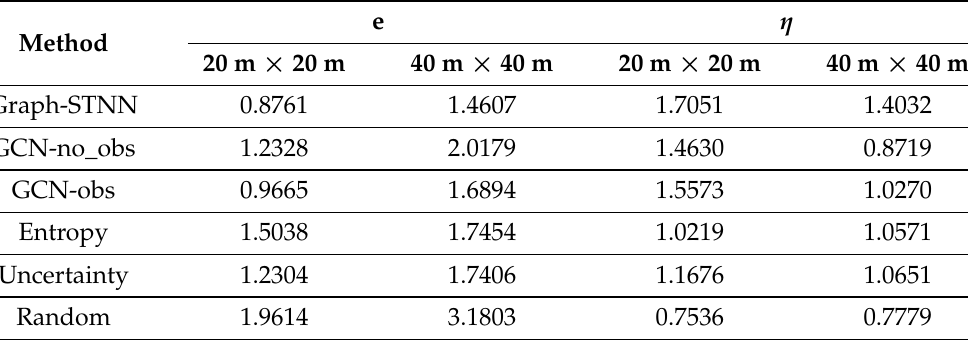
Figure 11. The results of 50 exploration trials of Graph-STNN, GCN-obs, GCN-no_obs, entropy- based, uncertainty-based and random methods , with the same randomly initialized landmarks and robot start locations, on 40 m × 40 m maps (the models are trained in 20 m × 20 m grid maps, and the results shown are plotted per time-step of the simulation). ( a ) One of the test result of 50 exploration trials. ( b ) Average exploration rate (left), trajectory error (middle), and exploration efficiency (right). Table 2. The average trajectory error and average exploration efficiency of different methods with the size of 20 m × 20 m and 40 m × 40